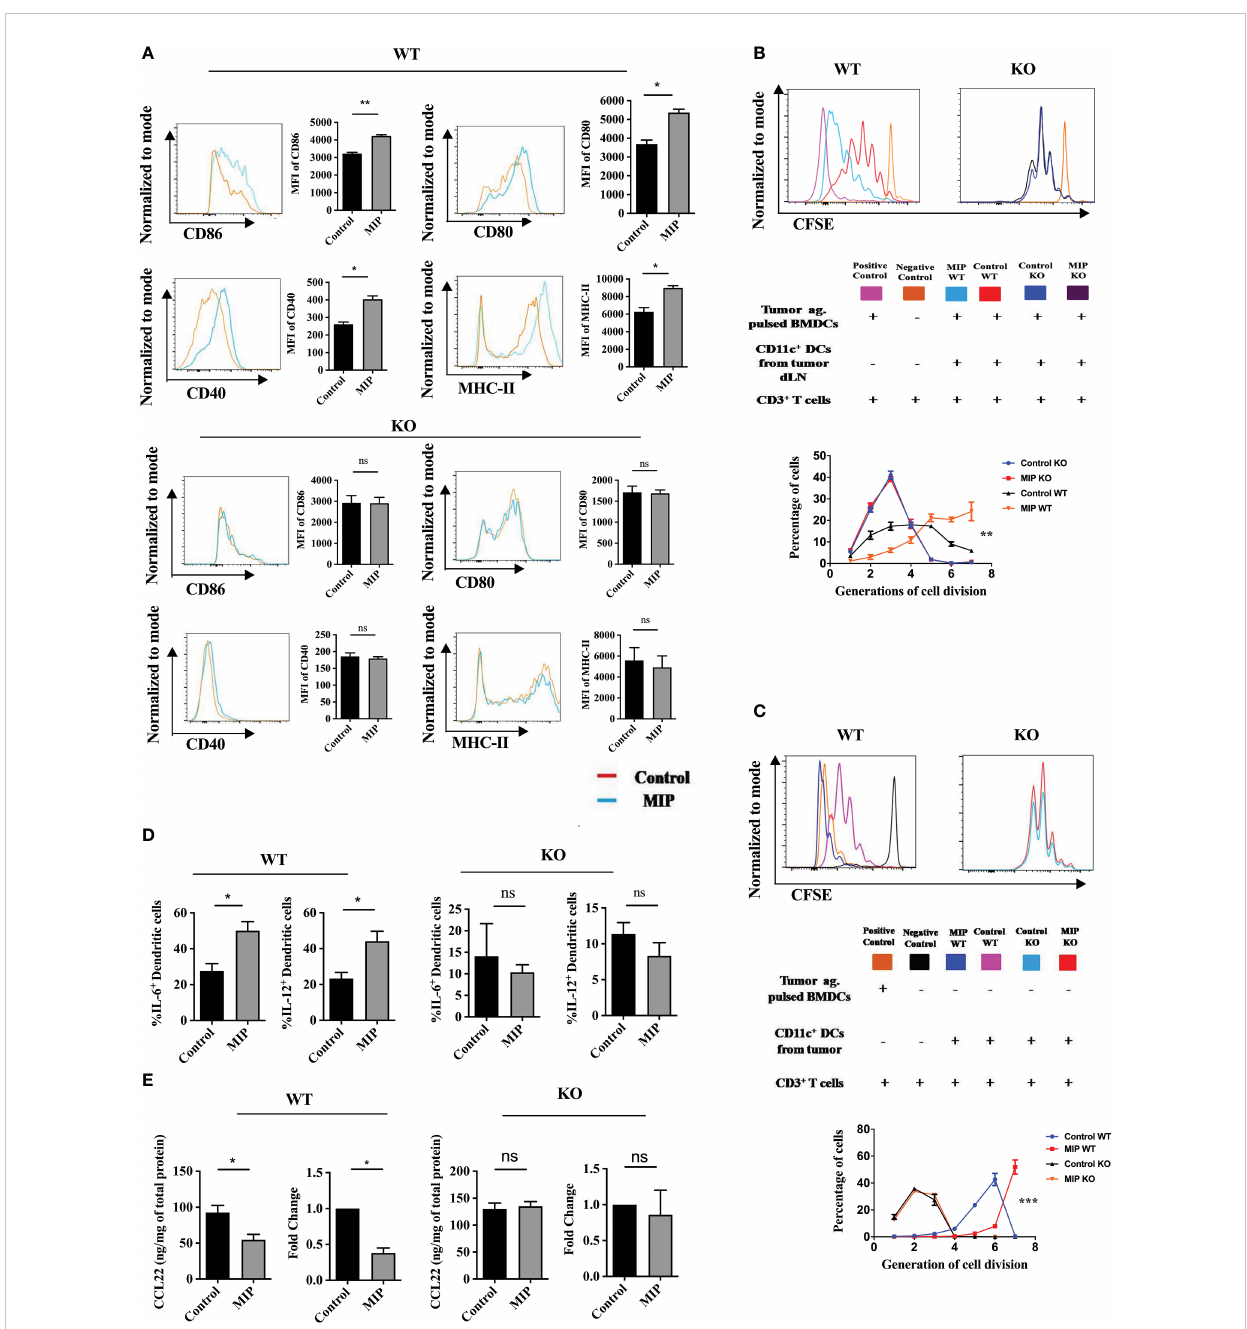
FIGURE 6 Role of type 1 IFN in remodulation of Ti-DCs in the MIP treated TME: (A) Activation and maturation markers on Ti-DCs including CD80, CD86, MHC-II and CD40 were analyzed by fl ow cytometry in wild type and IFNR1 -/- mice. Representative histogram plots indicate MFI of each activation marker (n = 5). (B) Ex-vivo DC suppression assay: CFSE labeled tumor-speci fi c CD3 + T cells were obtained as described earlier. These were added to culture wells containing tumor pulsed BMDCs (1:1). Sorted Ti-DCs either from Control or MIP treated tumor of wild type or IFNR1 -/- mice were co- incubated with these cultures in a 1:1:1 ratio (T cell/pulsed BMDC/sorted DC). The histogram plot is a representative of CFSE dye dilution which indicates tumor speci fi c T cell proliferation of one mouse per group (proliferation induced by tumor pulsed BMDCs in the presence of WT or IFNR1 -/- Ti-DCs). The line graph represents percentage of tumor speci fi c T cells in each generation of cell division (n = 5 mice/group). For the line graph, statistical signi fi cance was determined by two-way ANOVA. (***:p=0.0001 ; **:p<0.01) (C) Ti-DC mediated T cell proliferation assay: CFSE labeled tumor-speci fi c CD3 + T cells were co-cultured with Ti-DCs sorted from tumor bearing wild type or IFNR1 -/- mice treated with or without MIP (T cell: TI-DC ~ 10: 1) (n = 4 mice/group). (D) The importance of type 1 IFN in inducing the function of Ti-DCs after MIP immunotherapy is demonstrated by the production of IL-12 and IL-6 from Ti-DCs. (E) A fter MIP treatment, mRNA levels of Ccl22 was determined from the tumor in fi ltrating DCs of WT and IFNR1 -/- mice (n = 4); Intratumoral levels of CCL22 was also analyzed by ELISA in all the four groups (n = 5). All the bar graphs represent results as means ± SEM of one experiment. Statistical analysis was performed using unpaired Student ’ s t test (*:p<0.05, **:p<0.01, ns, non-signi fi cant). Two independent experimental repeats were